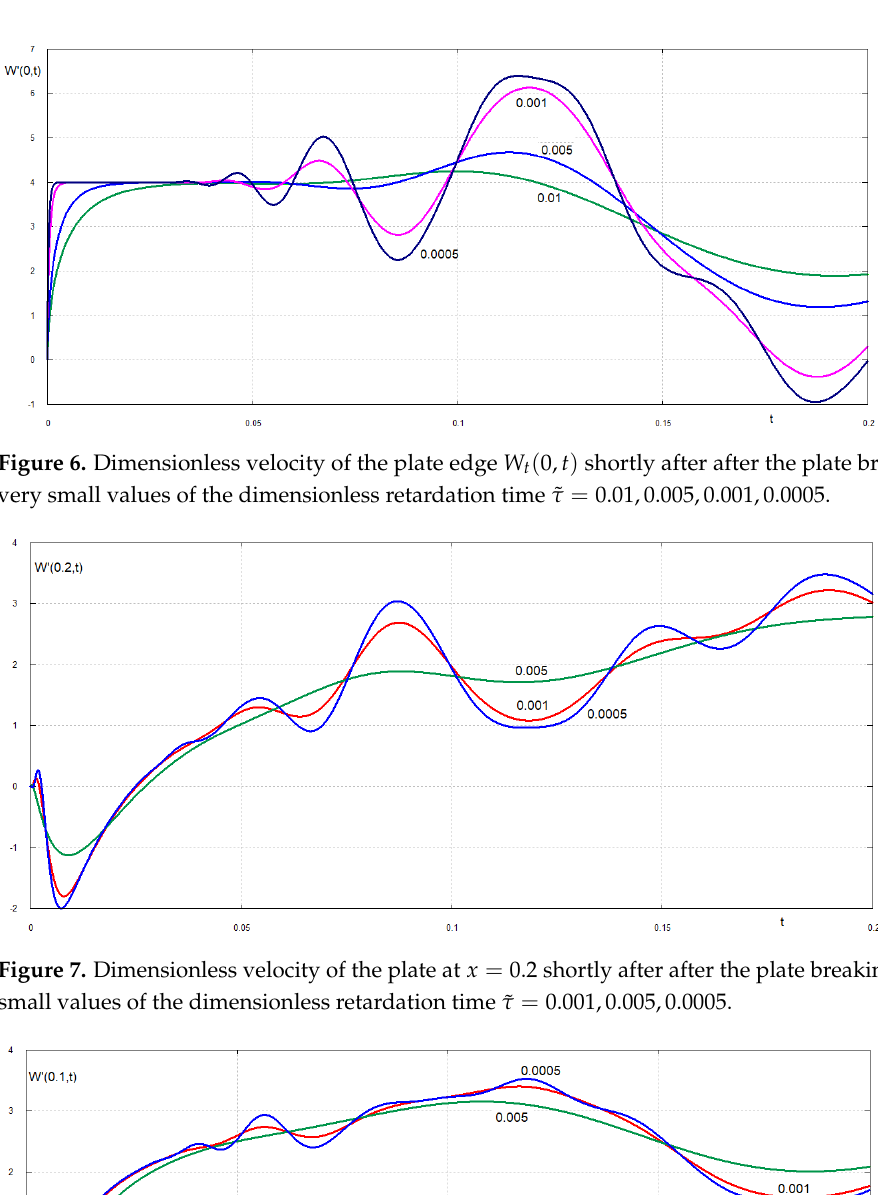
Calculations of the second derivative, W xx ( x , t ) , require the second derivatives ψ (cid:48)(cid:48) of the normal modes. Note that ψ (cid:48)(cid:48)